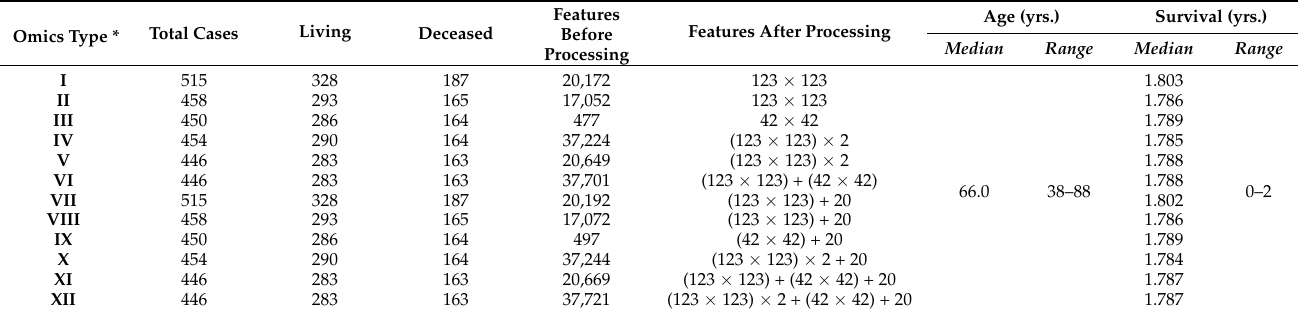
Table 2. Overall statistics for all the omics data-type combinations for SurvCNN.